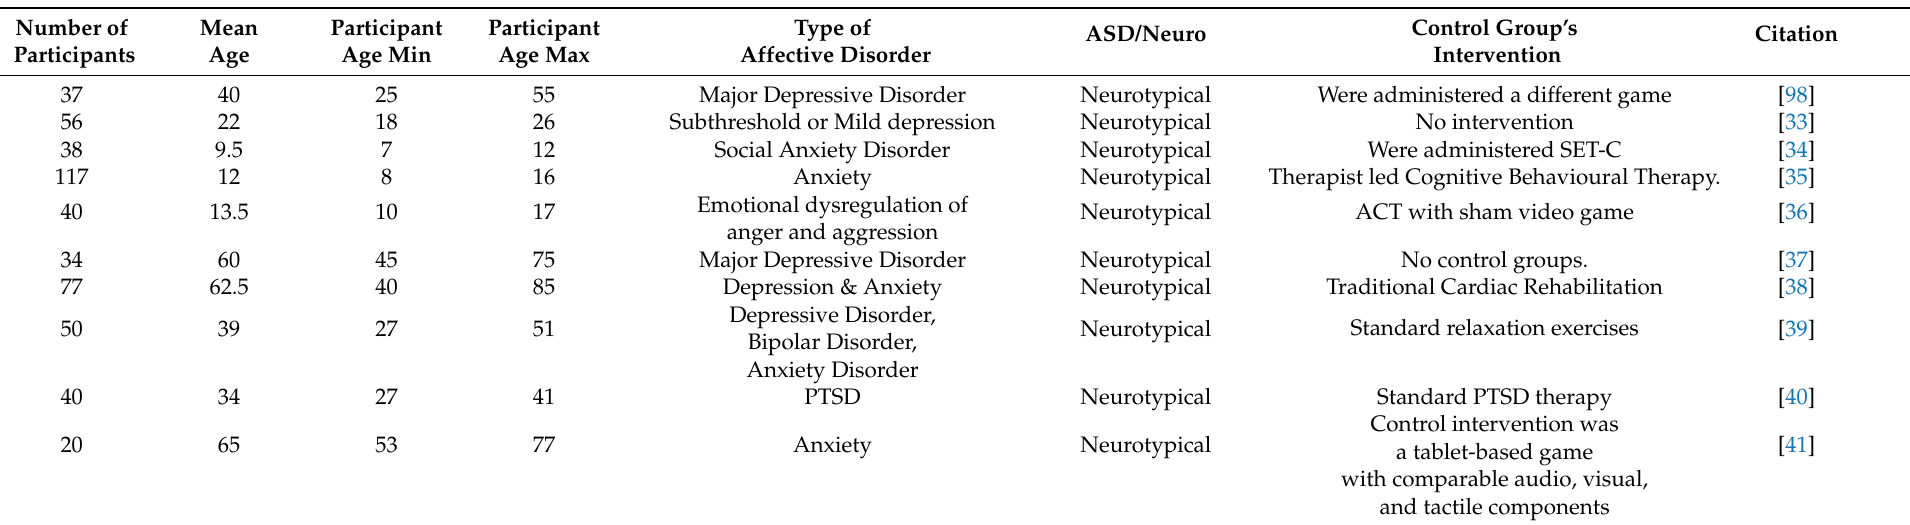
Table 3. Participant information of the selected